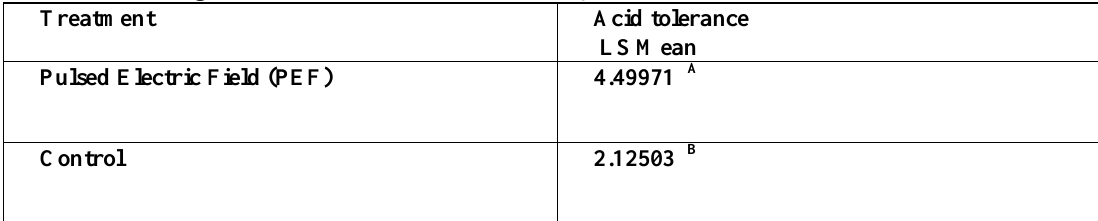
Table 2: Least square means for acid tolerance of Lactobacillus delbrueckii ssp. bulgaricus LB-12 as influenced by mild pulsed electric field